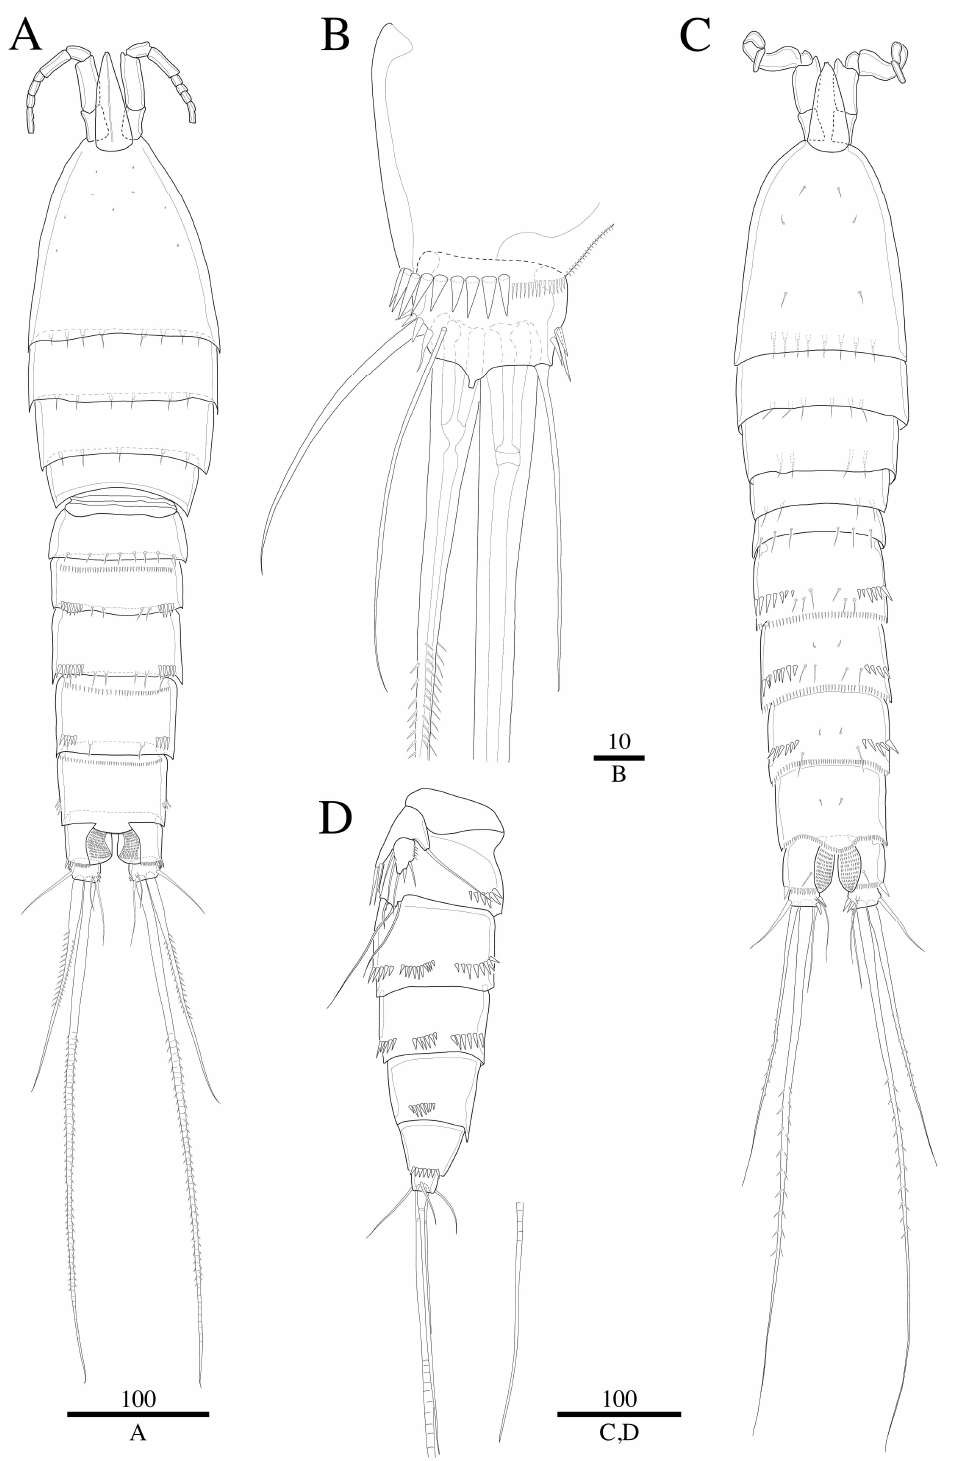
Figure 2. Robertgurneya jejuensis sp. nov. Female. ( A ) Habitus, dorsal. ( B ) Caudal ramus, ventral. Male. ( C ) Habitus, dorsal. ( D ) Urosome, lateral. Scale bars: 100 μm (A, C, D); 10 μm (B).